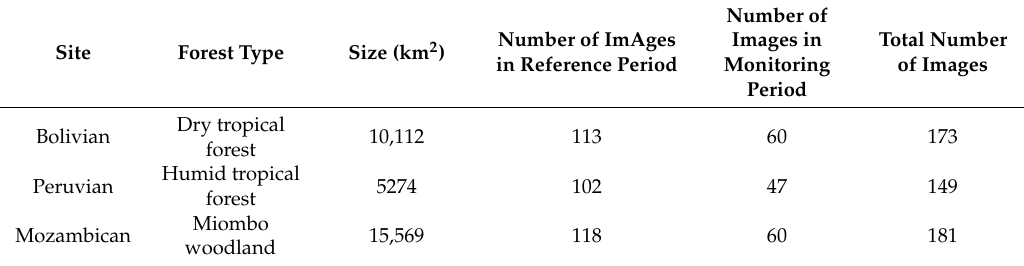
Table 1. The size, forest type, and the number of Landsat images available for each study